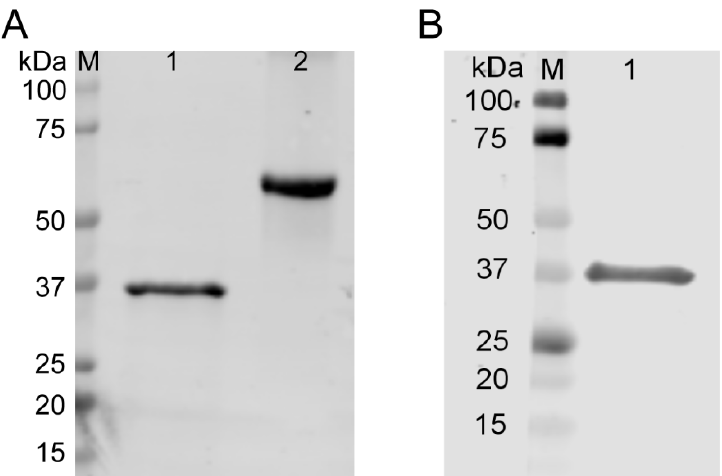
Figure 1. Validation of TAT-AKR1C15 fusion protein. TAT-AKR1C15 protein with His tag synthesized by Biomatik was subjected to electrophoresis and transferred onto the polyvinylidene difluoride (PVDF) membrane. ( A ) Total protein staining. M: marker; Lane 1: TAT-AKR1C15; Lane 2: bovine serum albumin (BSA). ( B ) Western blotting with anti-His antibody. M: marker; Lane 1: TAT-AKR1C15.